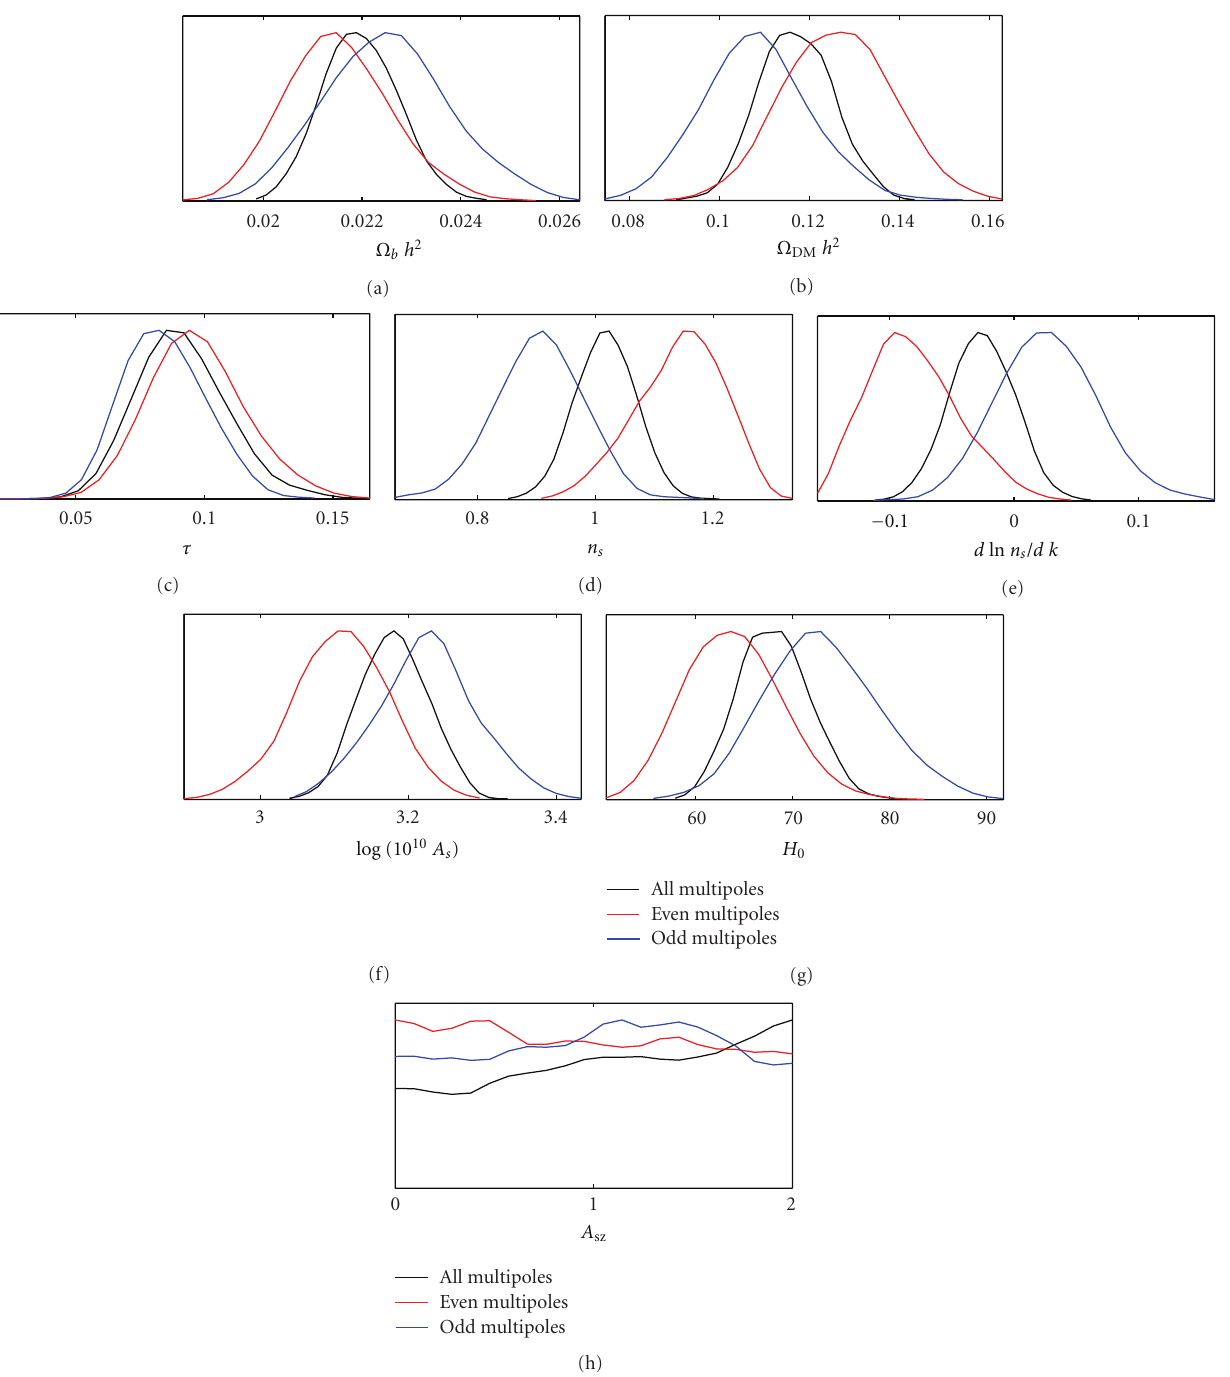
Figure 16: Marginalized likelihood of cosmological parameters ( Λ CDM + sz + lens + run), given whole, even, and odd multipole data,